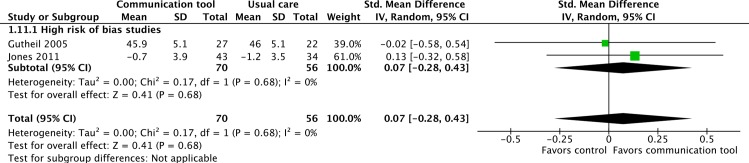
Quality of communication score between patients and health care providers.